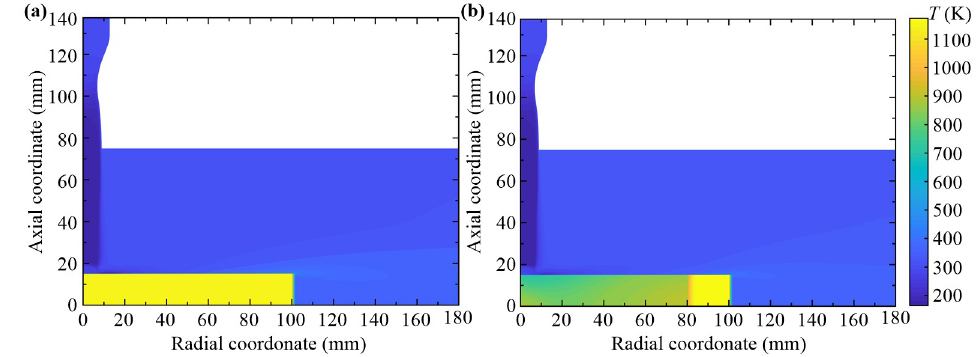
Fig 10. Temperature field distributions of the forced air quenching. (a) Steady-state flow, (b) Heat transfer at 50 s.